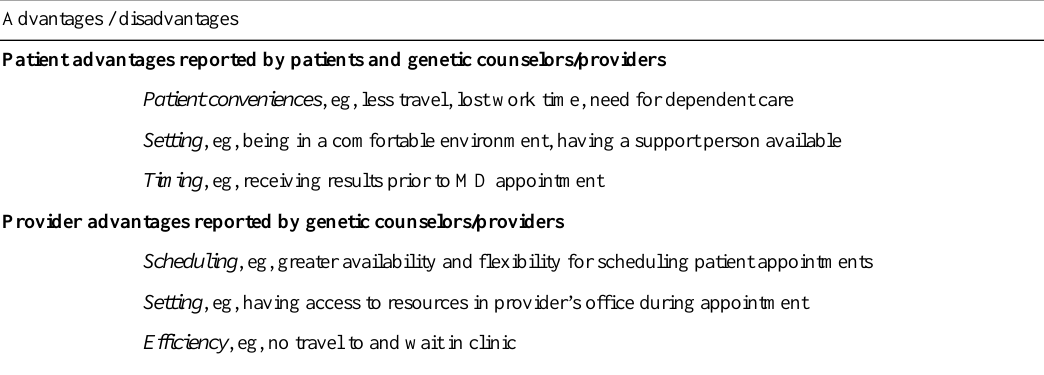
Table 3. Advantages and disadvantages to telephone disclosure: open-ended survey responses from patients and providers. a